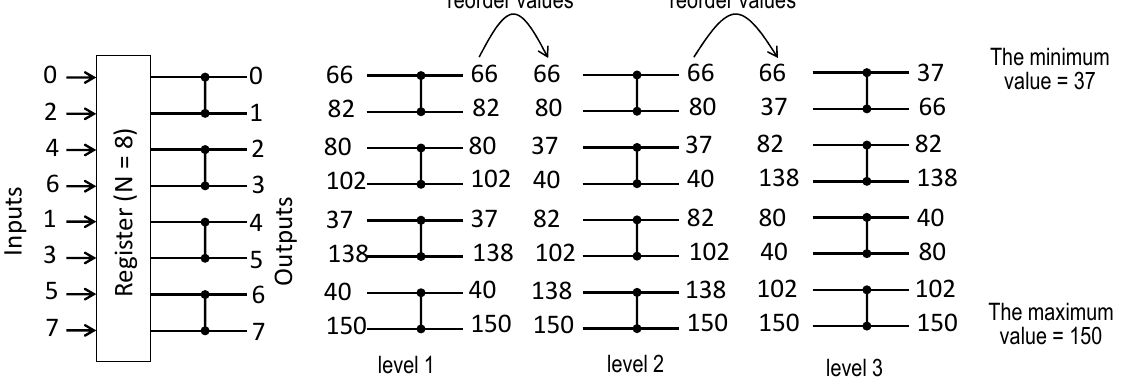
Figure 4. Network of comparators with a feedback register for finding the minimum and the maximum data items.